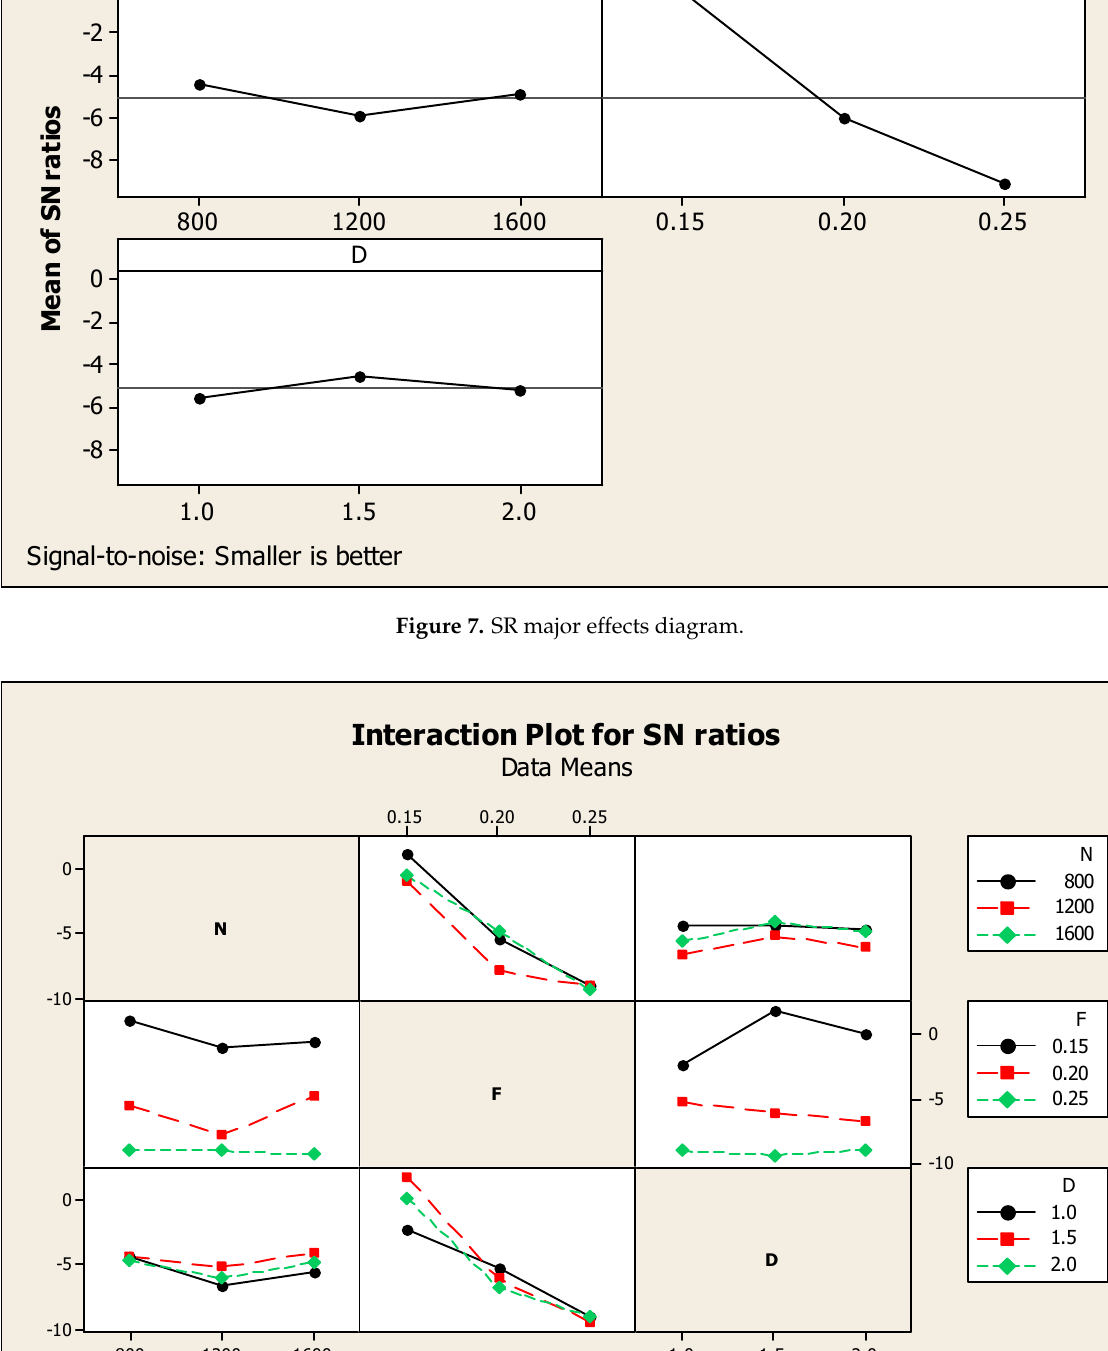
Figure 8. SR diagram for interaction.